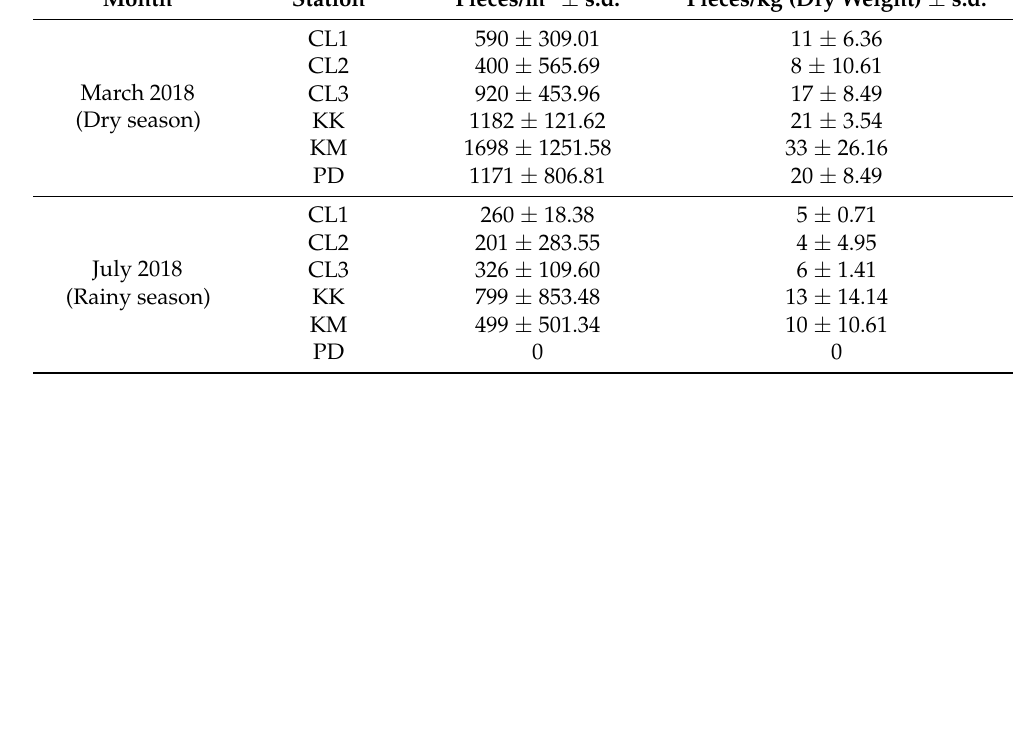
Table 2. Mean and standard deviation (SD) of microplastic particles per 1 square meter of the sampling area and 1 kg dry weight of sediment sample. Month Station Pieces/m 2 ± s.d. Pieces/kg (Dry Weight) ±